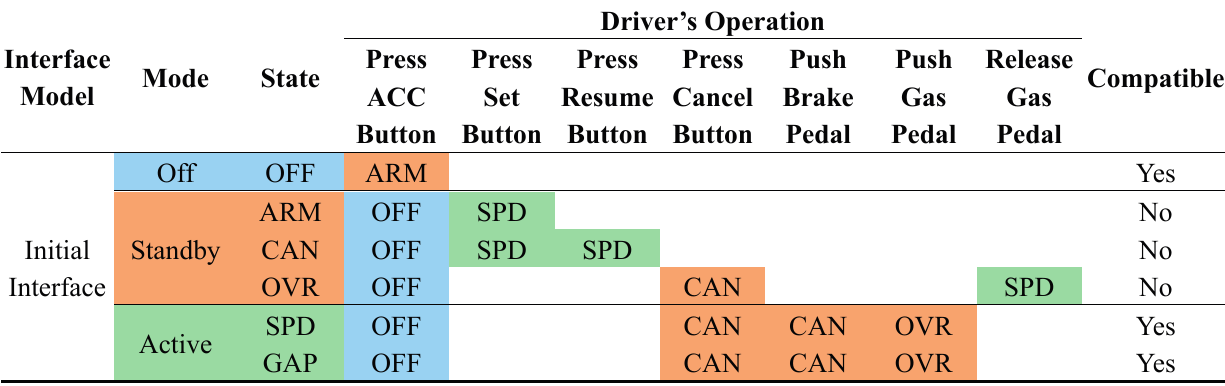
Table 4. User-triggered transitions between states and modes in the proposed interface